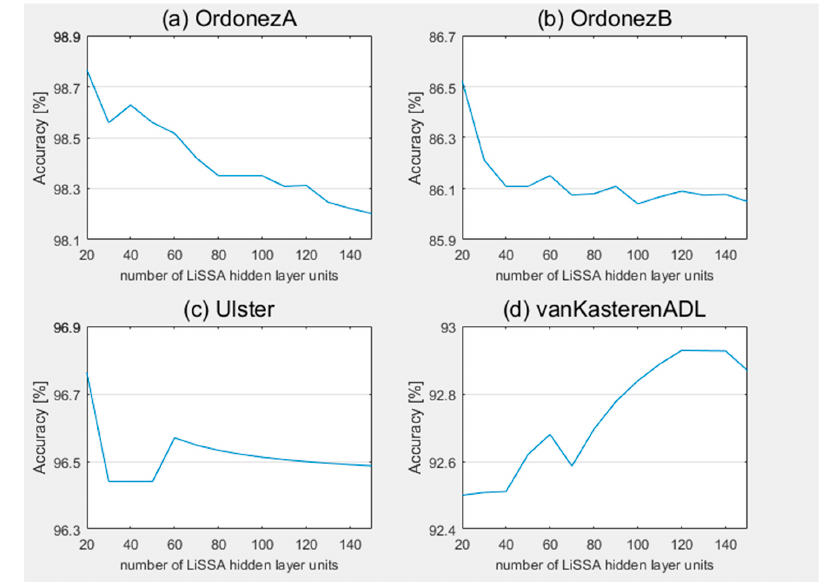
Figure 3. Accuracy of proposed method with different number of LiSSA hidden layer units on datasets ( a ) OrdonezA, ( b ) OrdonezB, ( c ) Ulster, and ( d ) vanKasterenADL. Sensors 2020 , 20 , x FOR PEER REVIEW